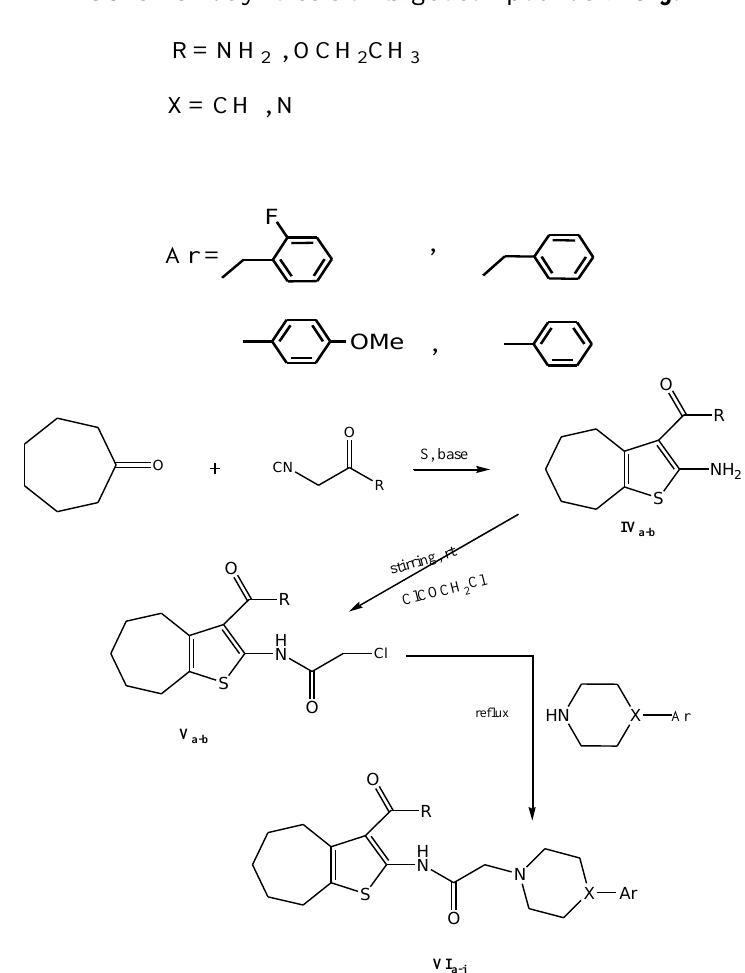
Scheme 2. Synthesis of target compounds VIa-j